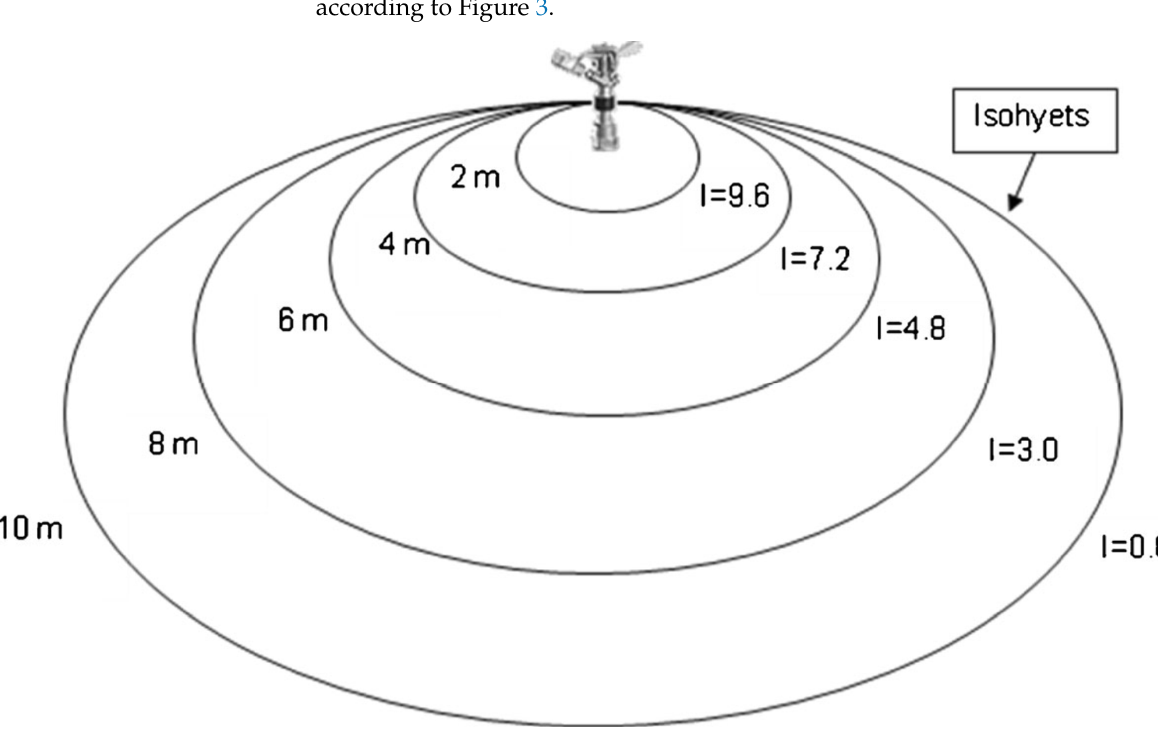
Figure 3. Point source experimental design was applied in the Salgados golf course. Irrigation gradient was expressed by the daily net irrigation rates (I, mm d − 1 ) and the distance from the sprinkler in meters. The irrigation circle was divided into salt treatment sectors.